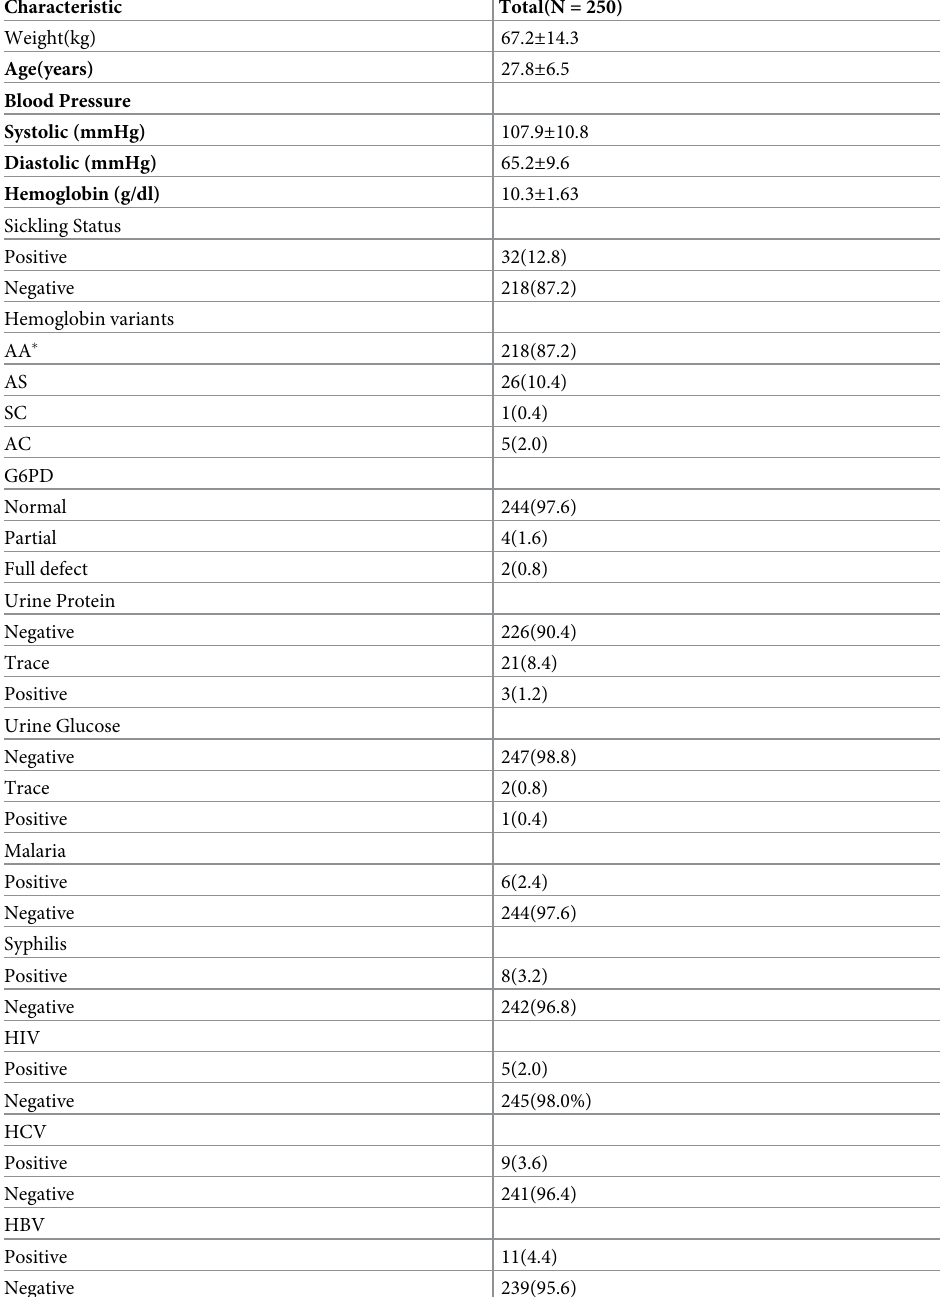
Table 1. Summary of demographic and clinical characteristics of the pregnant